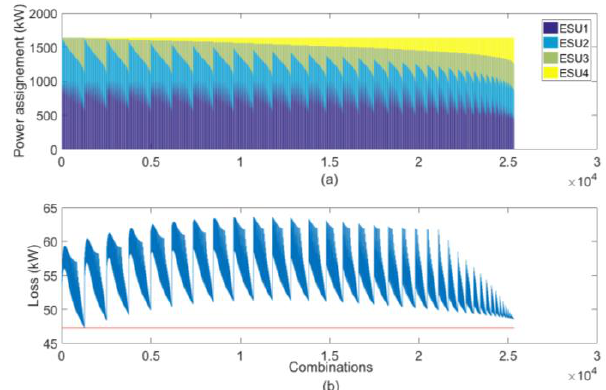
Figure 10. Loss comparison between all-space search and genetic algorithm results: ( a ) ESU combinations, and; ( b ) loss by ESU combinations.